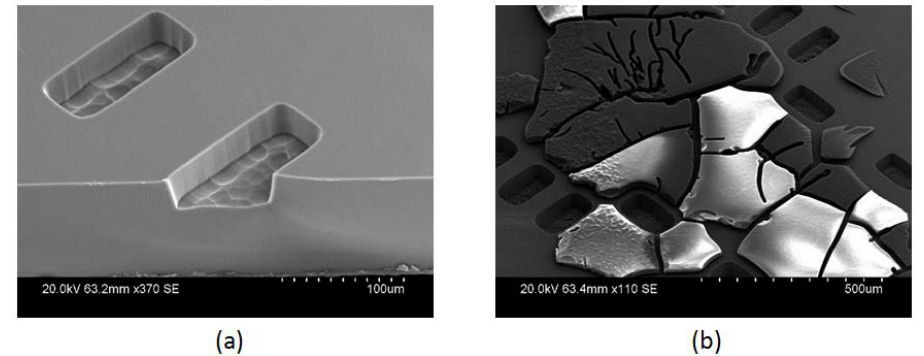
Figure 3. Scanning electron microscopy (SEM) micrographs: ( a ) The etched fused silica using the optimal recipe; ( b ) Over burnt KMPR 1035 residual.